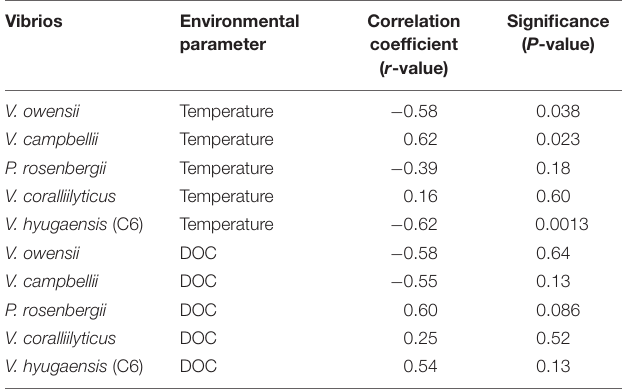
TABLE 1 | Correlation coefficient ( r ) and significant levels ( P -values) obtained from the correlation analysis between major Vibrio abundances and environmental